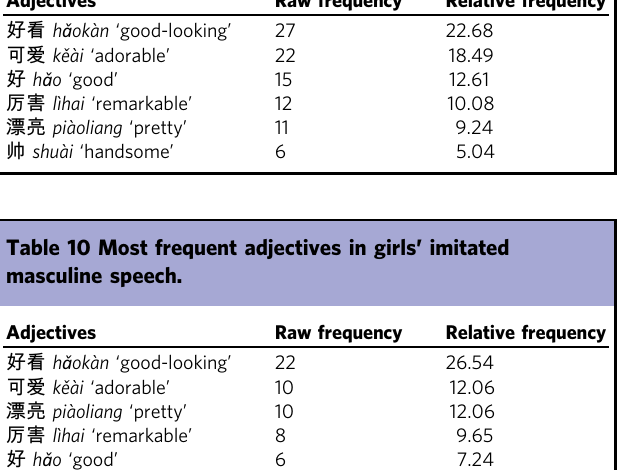
Table 6 Top 10 words in girls ’ imitated masculine speech. Word types